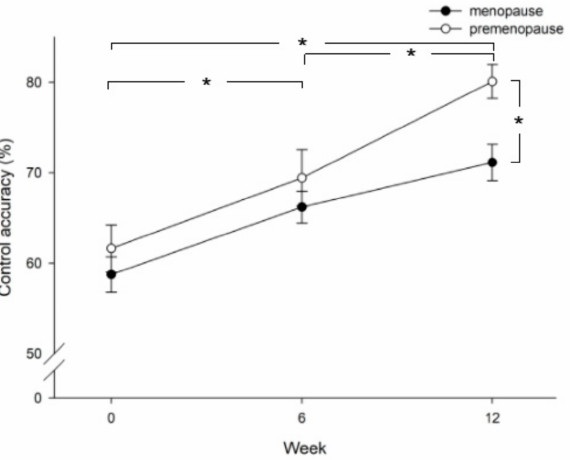
Figure 2. Comparison of control accuracy between patients in the pre-menopause and menopause stage at baseline (week 0), week 6, and week 12 after intervention. Significant differences are shown between menopause and pre-menopause groups ( p = 0.013) and at week 12 vs. baseline ( p = 0.000), week 6 vs. baseline ( p = 0.036), and week 12 vs. week 6 ( p = 0.002); *, p < 0.05.